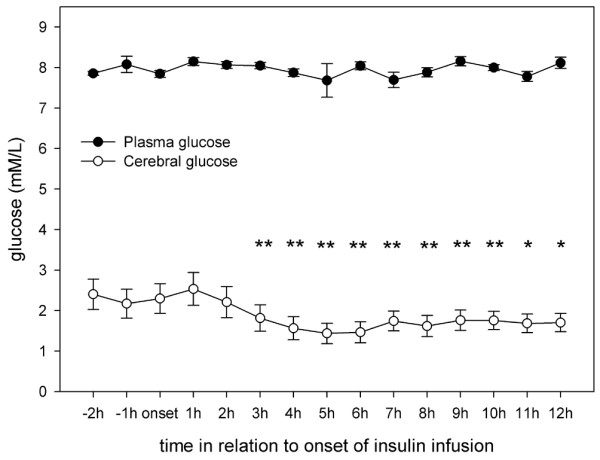
Course of blood and cerebral extracellular glucose during insulin infusion. Data are expressed as mean ± standard error of blood glucose and hourly microdialysate concentrations from 24 patients treated with continuous intravenous insulin. Blood glucose levels were not available for every single hour from every patient (see text for details). Levels of significance are indicated for comparison with microdialysate concentrations at the start of insulin infusion (Wilcoxon signed-rank test). **P < 0.01; *P < 0.05.